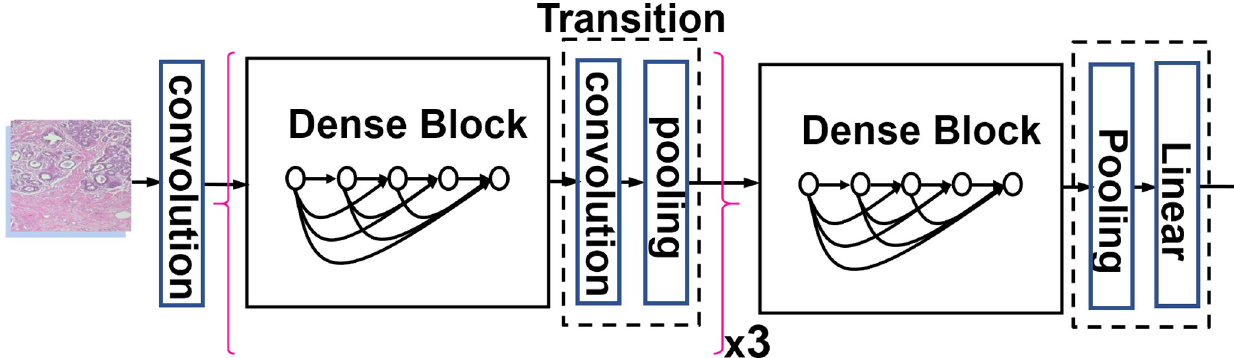
Fig 1. The DenseNet-121 architecture.